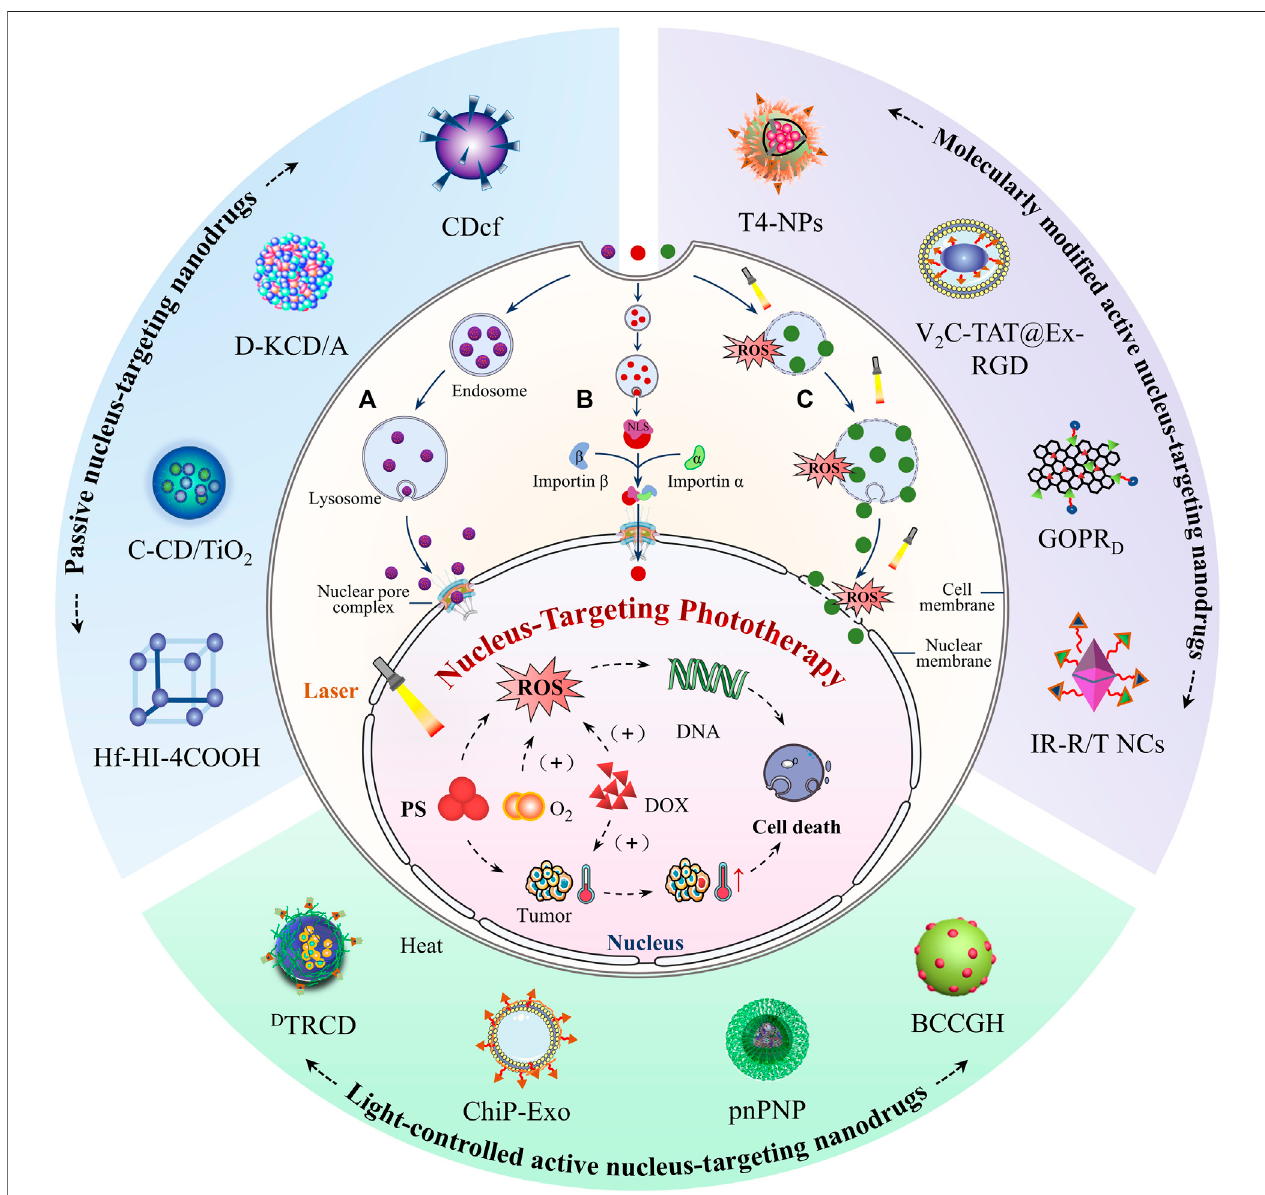
FIGURE 1 | Schematic illustration of nucleus-targeting nanodrugs for enhancing PDT and PTT. According to the way nanodrugs targeting the nucleus, they are divided into two parts: passive nucleus-targeting nanodrugs (A) and active nucleus-targeting nanodrugs, which are further divided into molecularly modi fi ed active nucleus-targeting nanodrugs (B) and light-controlled active nucleus-targeting nanodrugs (C) . In (A) , nanodrugs that undergo size/hydrophilicity adjustment can passively penetrate the nucleus through NPCs after escaping from the endo/lysosome. In (B) , after being modi fi ed with the nucleus-targeting groups, nanodrugs can be recognized and then transferred into the nucleus by importin α / β through NPCs. As for (C) , ROS generated by nanodrugs under light irradiation will destroy a seriesofbio-membranes and facilitate theentry ofnanodrugs into the nucleus. Nanodrugs accumulated in the nucleus generated alarge amount oftoxic ROSand local high temperature under light irradiation to destroy DNA and proteins in the nucleus and fi nally induce tumor cell death.